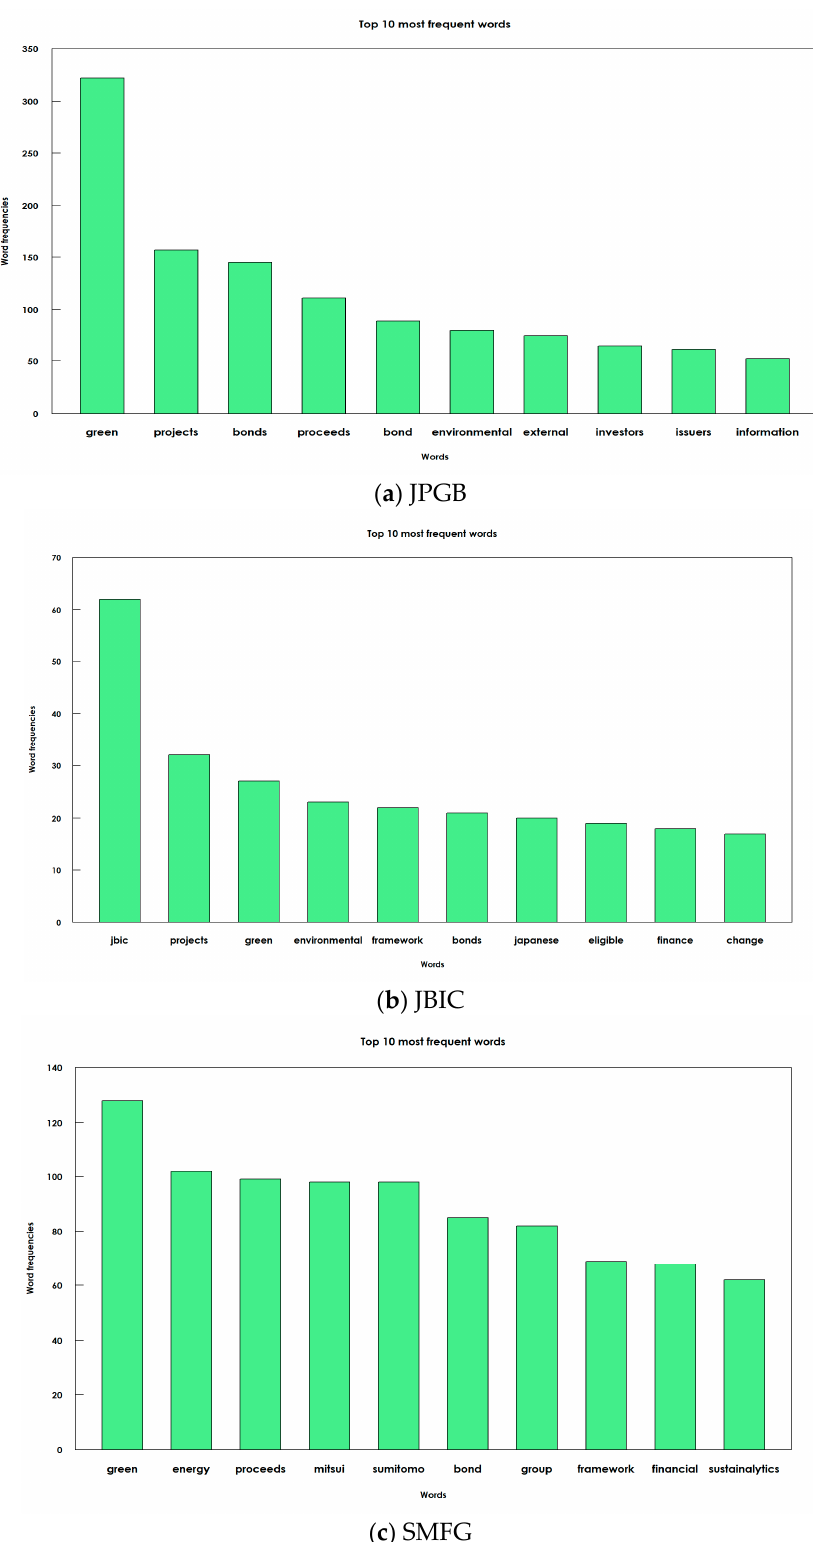
Figure 3. Most frequent words in the Japanese guidelines and frameworks . According to Figures 2 and 3, the word “green” recorded the highest frequency for the GBP, JPGB, and SMFG frameworks, and it was also the third most frequent word in the JBIC framework. On the other hand, the word “climate”, the most frequent word in